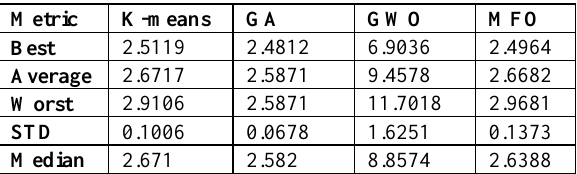
Table 1. Performance of different